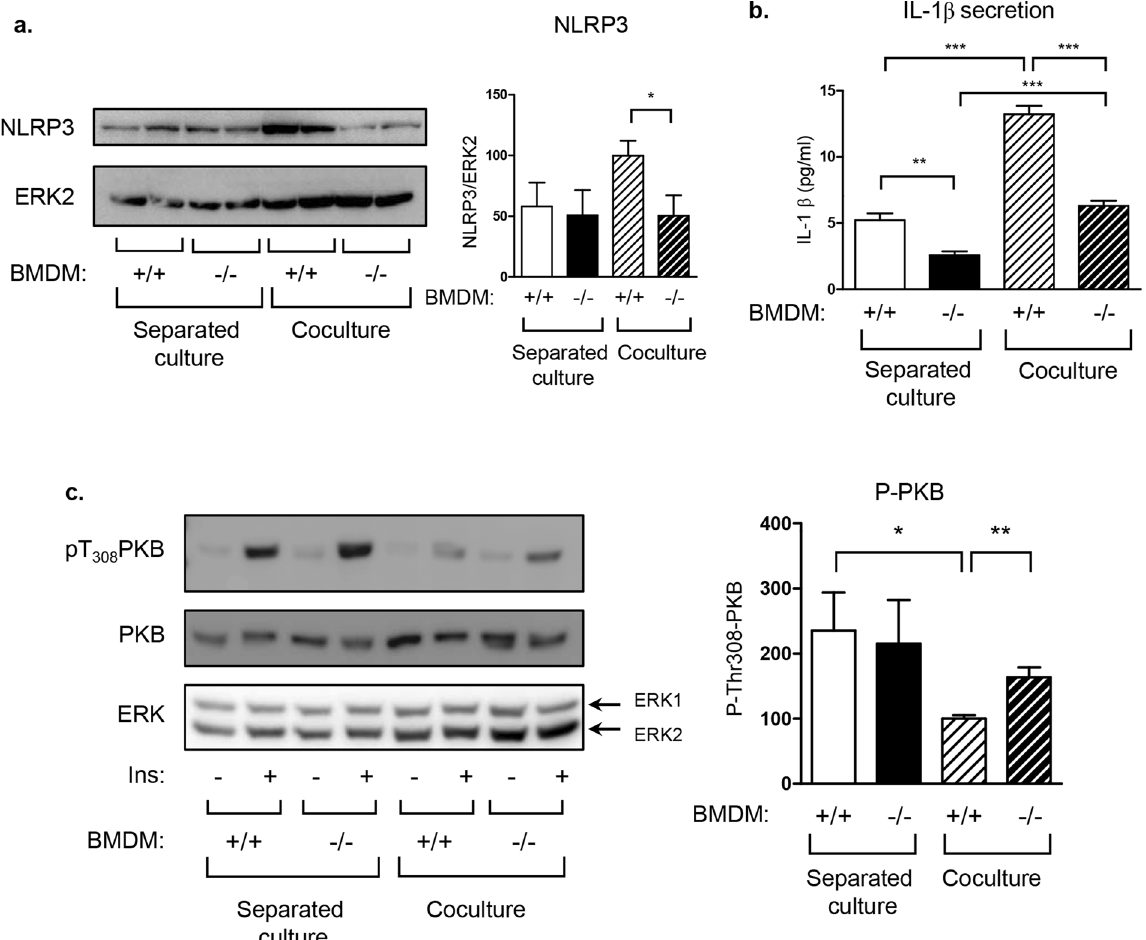
Figure 6. Invalidation of REDD1 in macrophages decreased IL-1 β secretion in adipocyte-macrophage coculture. REDD1 + / + or REDD1 − / − BMDM were primed with LPS 100ng/ml for 3 hours before being cultured separetely or cocultured with 3T3-L1 adipocytes for 24 hours. ( a ) Cell lysates were analyzed by immunoblots with indicated antibodies. Quantification of NLRP3 (normalized to ERK2) is shown. ( b ) IL-1 β concentration was determined by elisa test in the culture supernatant. ( c ) Cells were stimulated with insulin (1 nM) for 5 minutes and cell lysates were analyzed by immunoblots with indicated antibodies. Quantification of pT 308 PKB with the value of coculture with BMDM REDD1 + / + treated with LPS taken as 100 (n = 4 independent experiments). * p < 0.05; ** p < 0.01; *** p <